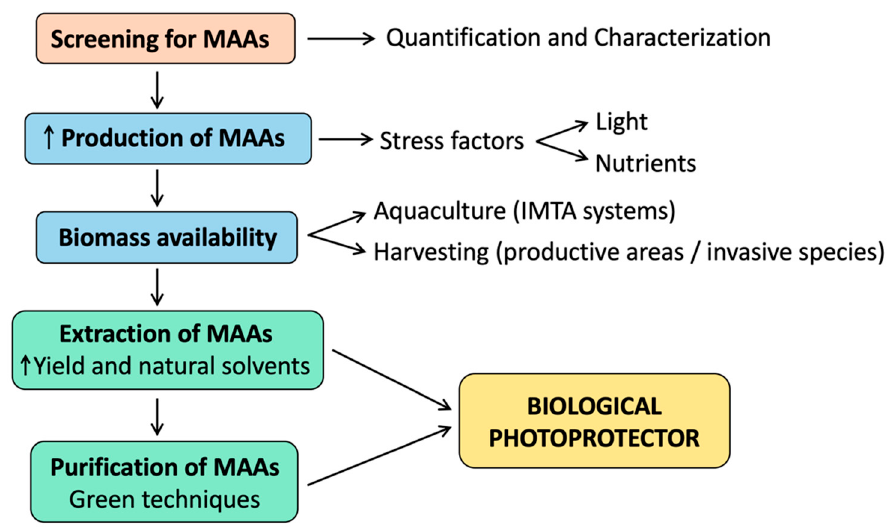
Figure 2. Scheme of the different steps of the process described in this review, involving screening, production, extraction, and